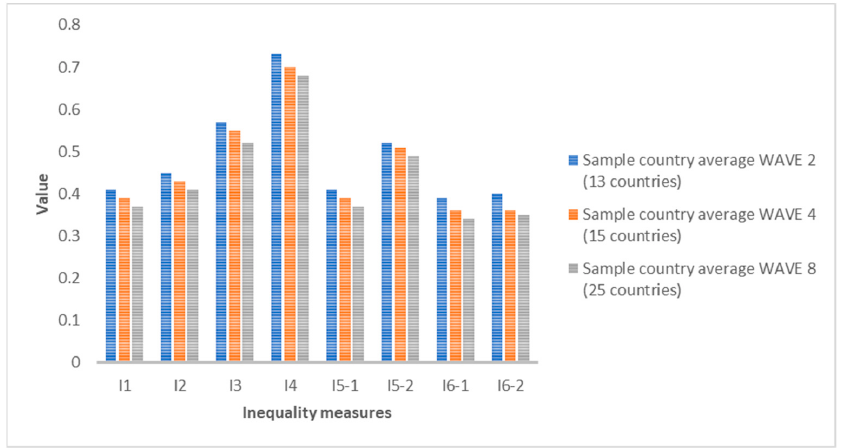
Figure 1. Average values for each inequality indicator for men in Wave 2 (2006), Wave 4 (2010) and Wave 8 (2020). Source: Authors’ elaboration based on SHARE (2021).